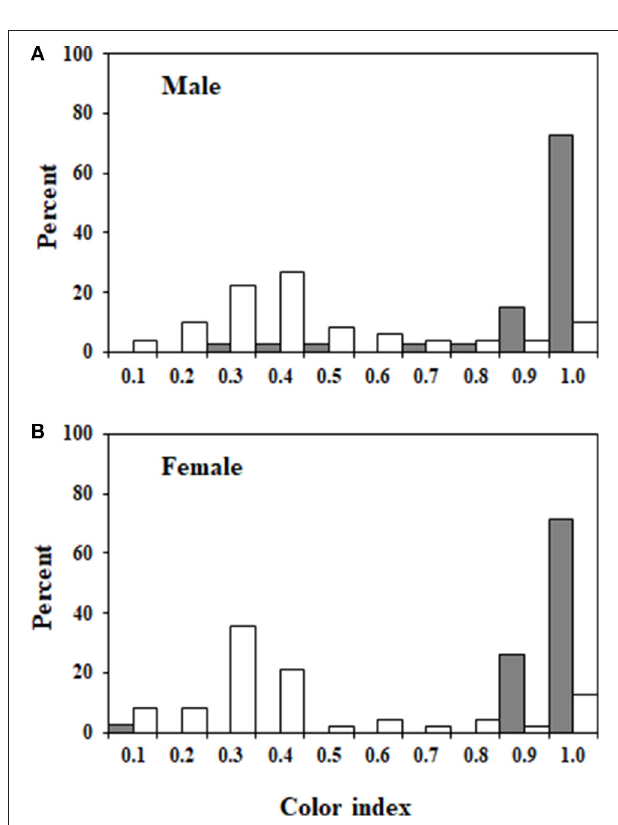
FIGURE 3 | Frequency distributions of color index values. Relative frequencies of color index measures for members of each of the four groups. (A) Uninfected and infected males. (B) Uninfected and infected females. Values ranged from 0 to 1 and represent measures of both color type and body coverage. A value of 1 represents an individual with dark brown coloration that is present over the entire dorsal surface of the body. Values for uninfected individuals are shown in gray and values for infected individuals are shown in